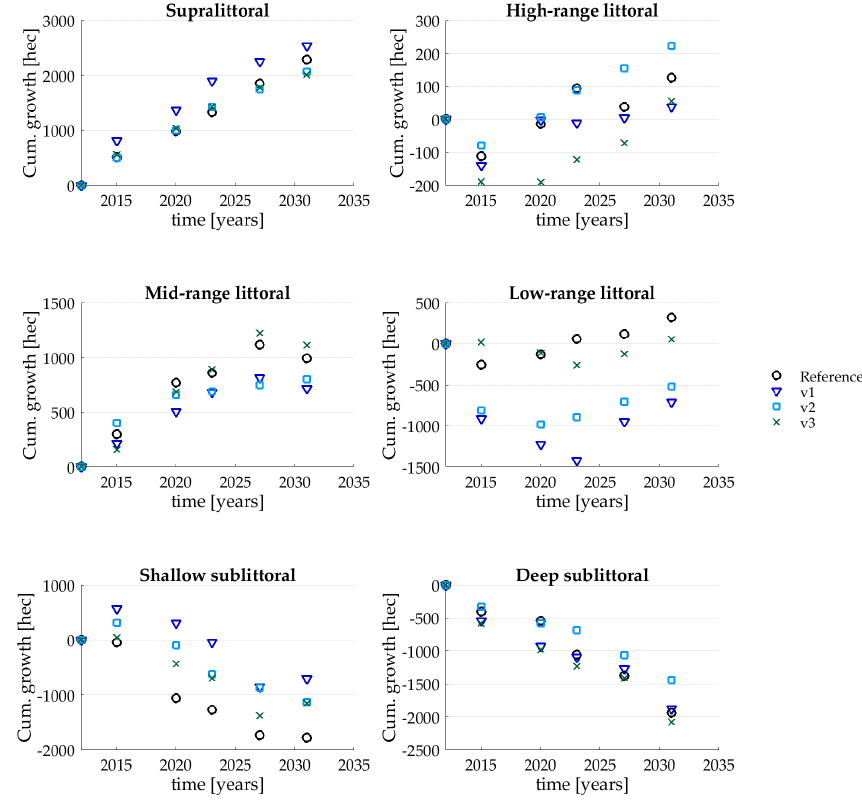
Figure 11. Net cumulative ecotope growth during 20 years for v1, v2, v3 and the reference case.